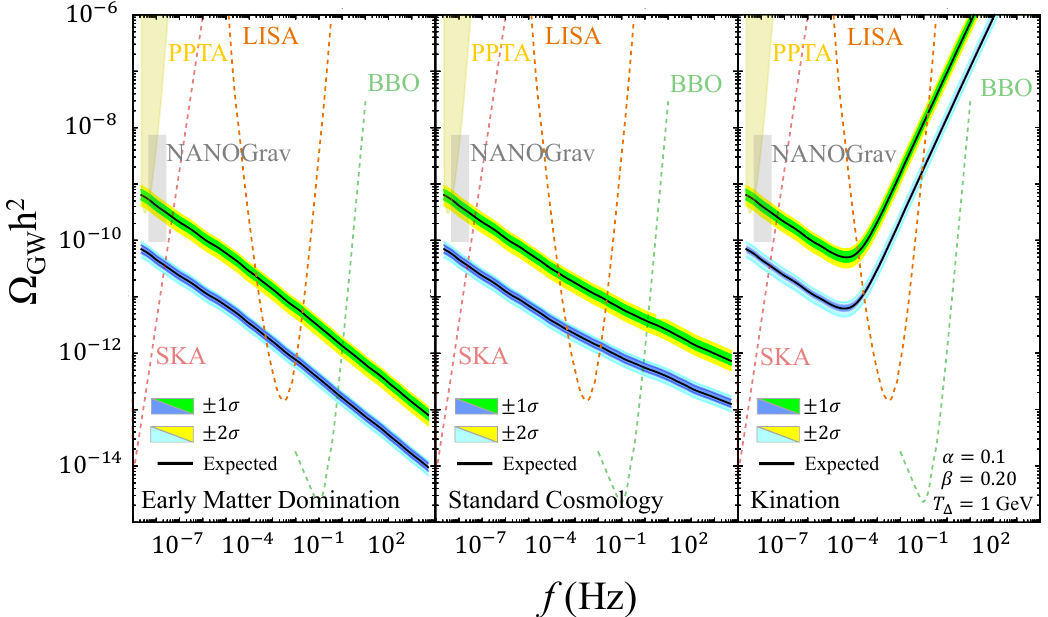
Figure 16 . An example of GW spectra from a global string network with a non-scaling solution eq. (2.9) in various cosmological backgrounds. Upper lines show the results with C , lower eff ∝ N lines show the results with C can be found in 3 / 2 . Details about the two scenarios of C eff ∝ N eff the main text. The black lines show the central values, while the yellow(Green) and cyan(Blue) areas represent the 2(1) sigma uncertainty range for the linear growth ξ = 0 . 24(2) N + 0 . 2 . A set of related experimental sensitivities are also